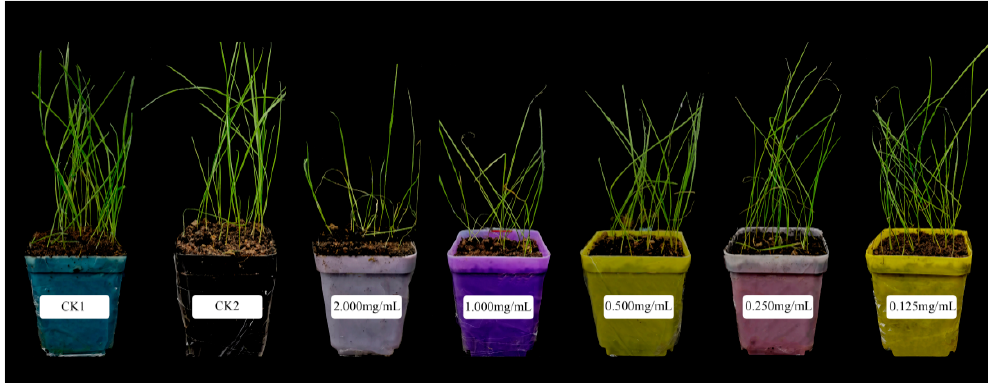
Figure 3. L. perenne in pot experiment (The concentration of potted plants from left to CK1 (blank control), CK2 (negative control), (2.000–0.125) mg/mL).